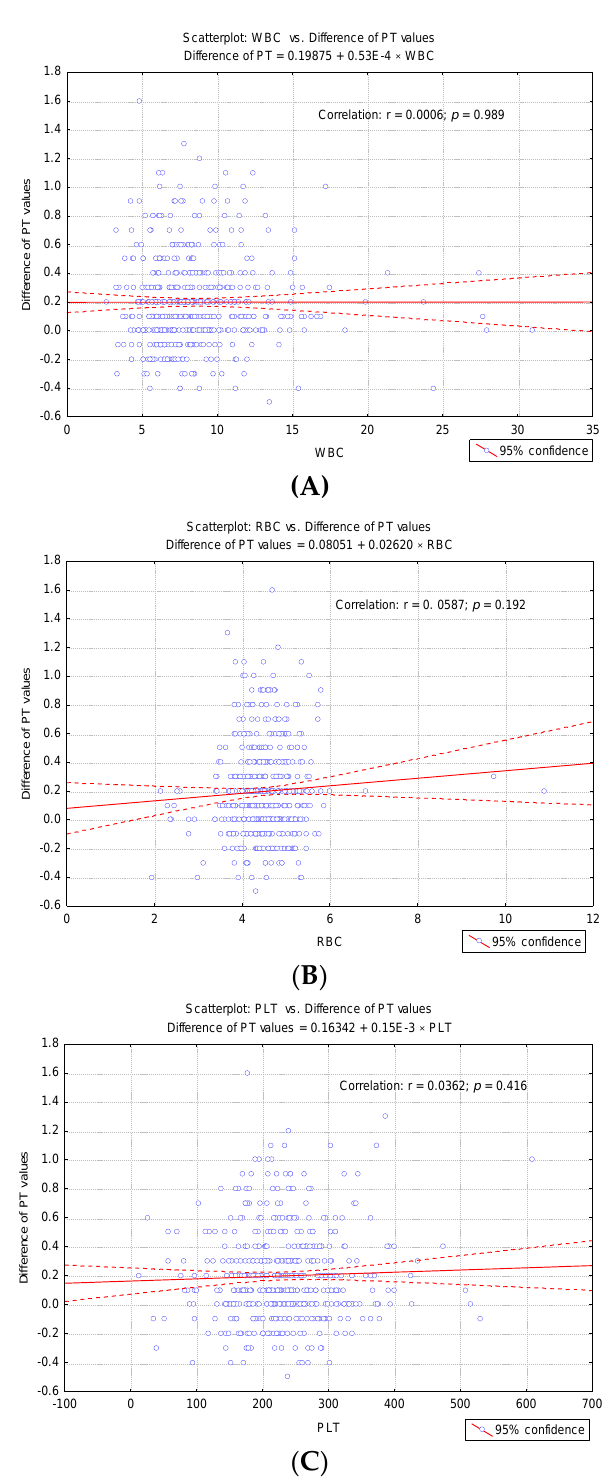
Figure 4. Regression line describing the variance of the PT test difference according to cellular